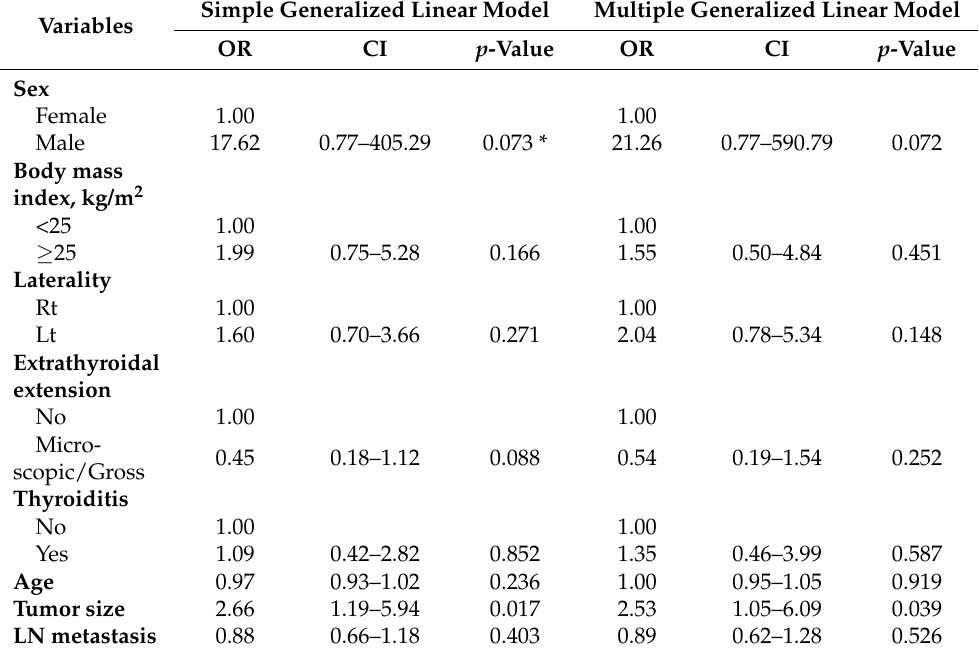
Table 4. Logistic regression analysis 1 of risk factors associated with long-time group (>112